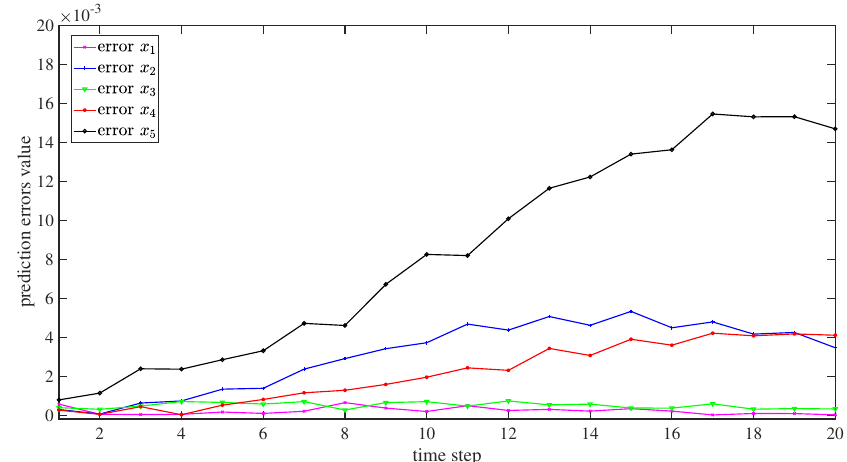
Figure 5. The progress of multi-step prediction.